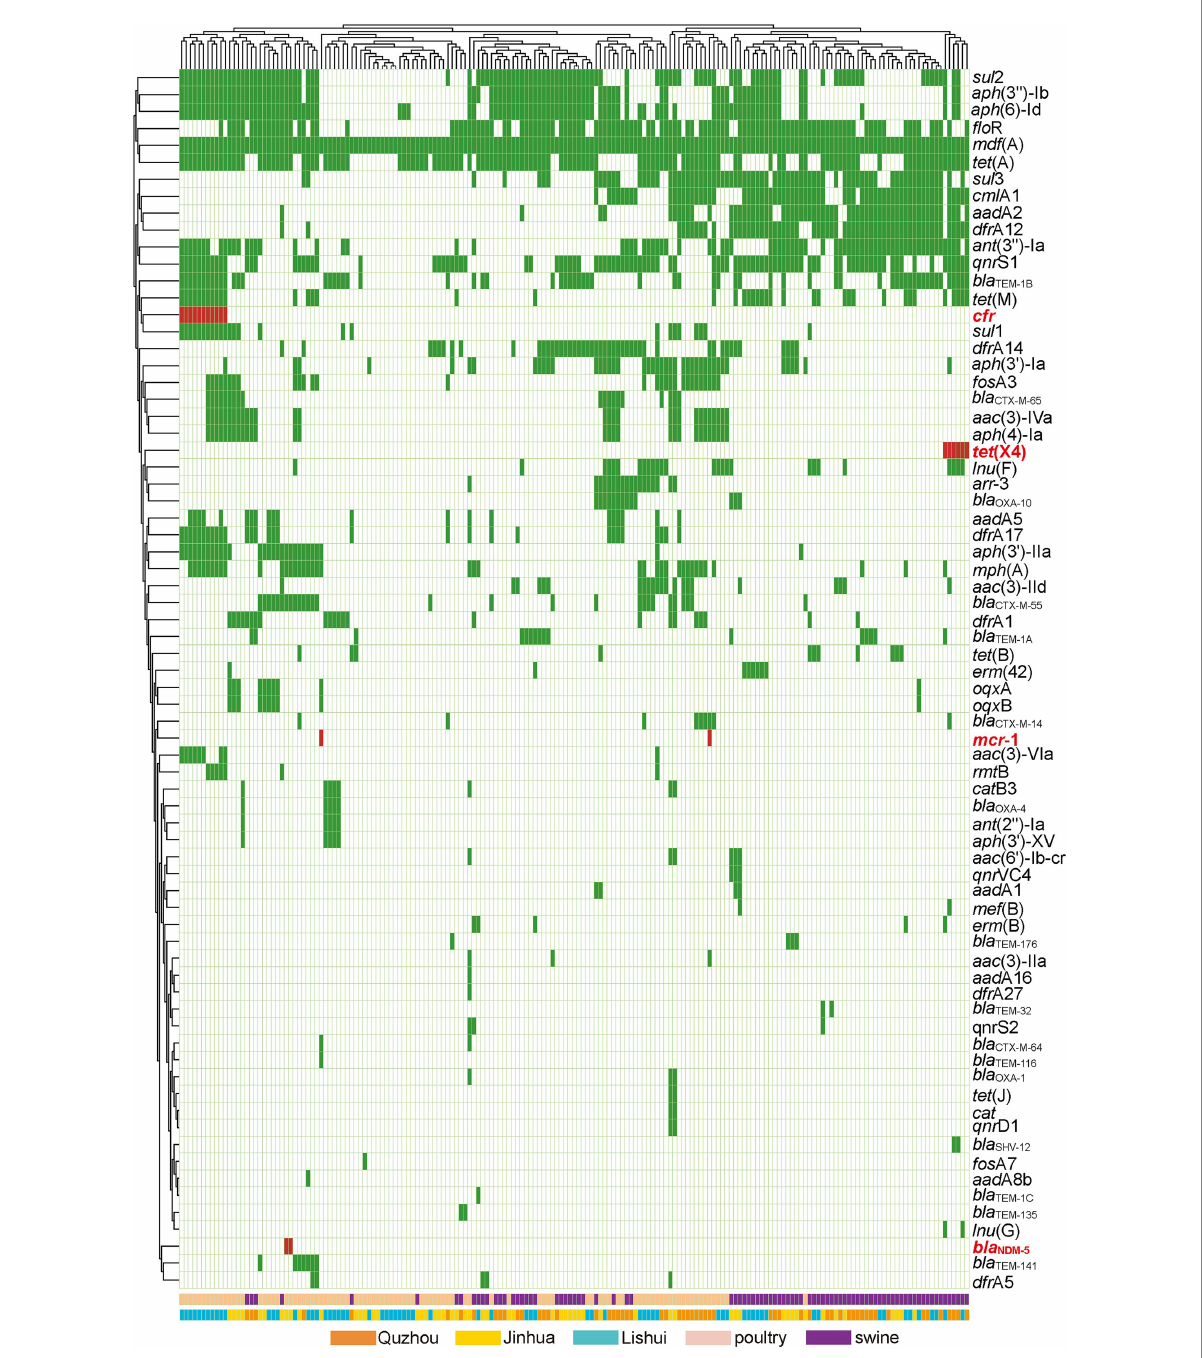
FIGURE 5 Antibiotic resistance patterns of E. coli isolates. Y-axis is the number of isolated strains, and x-axis is the selected AMR genes identified. Green indicates that the isolate is isolated from Quzhou sample, light blue indicates that it is isolated from Lishui, and light yellow indicates that it is isolated from Jinhua. Flesh color indicates that the isolate is isolated from poultry anal swab samples, and cinnabar indicates that it is isolated from pig anal swab samples. Dark green in the small grid indicates the presence of AMR genes, white indicates no, and red indicates the presence of risk AMR genes. The risk AMR genes mentioned here refer to the genes that have been focused on, such as tet (X4) (resistant to tigecycline), mcr-1 (resistant to colistin), bla NDM-5 (meropenem) or cfr (resistant to oxazolidinone, amphenicol, lincosamide), which pose a serious threat to public health and safety. Rifamycin (arr-3) , Aminoglycoside ( aac(3)-Iia , aac(3)-Iid , aac(3)-Iva , aac(3)-Via , aac(6 ′ )-Ib-c r, aadA16 , aadA1 , aadA2 , aadA5 , aadA8b , ant(2 ″ )-Ia , ant(3 ″ )-Ia , aph(3 ″ )-Ib , aph(3 ′ )-Iia , aph(3 ′ )-Ia , aph(3 ′ )-XV , aph(4)-Ia , aph(6)-Id , rmtB ), Beta-lactam ( bla CTX-M-14 , bla CTX-M-55 , bla CTX-M-64 , bla CTX-M-65 , bla NDM-5 , bla OXA-10 , bla OXA-1 , bla OXA-4 , bla SHV-12 , bla TEM-116 , bla TEM-135 , bla TEM-141 , bla TEM-176 , bla TEM-1A , bla TEM-1B , bla TEM-1C , bla TEM-32 ), Amphenicol ( catB3 , cat , cmlA1 , floR , cfr ), Folate pathway antagonist ( dfrA12 , dfrA14 , dfrA17 , dfrA1 , dfrA27 , dfrA5 , sul1 , sul2 , sul3 ), Macrolide ( erm(42) , erm(B) , mdf(A) , mef(B) , mph(A) ), Fosfomycin ( fosA3 , fosA7 ), Lincosamide ( lnu(F) , lnu(G) ), Polypeptides ( mcr-1 ), Quinolone ( oqxA , oqxB , qnrD1 , qnrS1 , qnrS2 , qnrVC4 ), Tetracycline ( tet (A), tet (B), tet (J), tet (M), tet